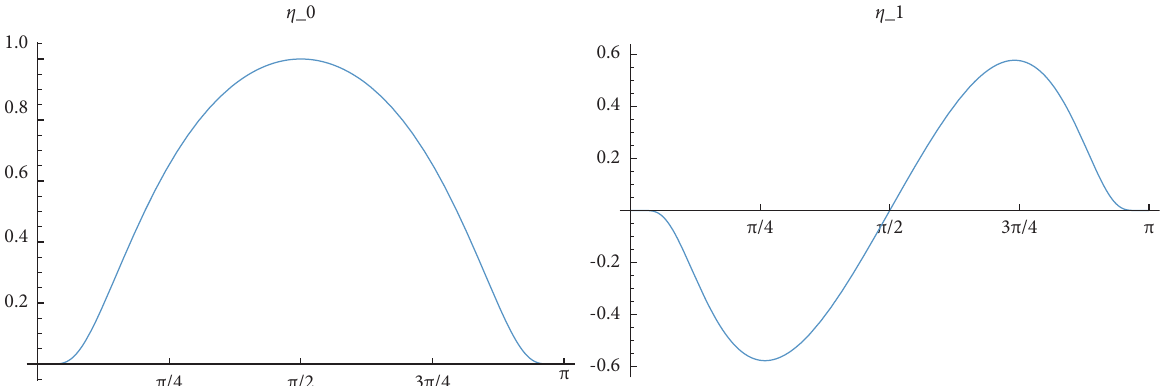
Figure 2: Graph of η